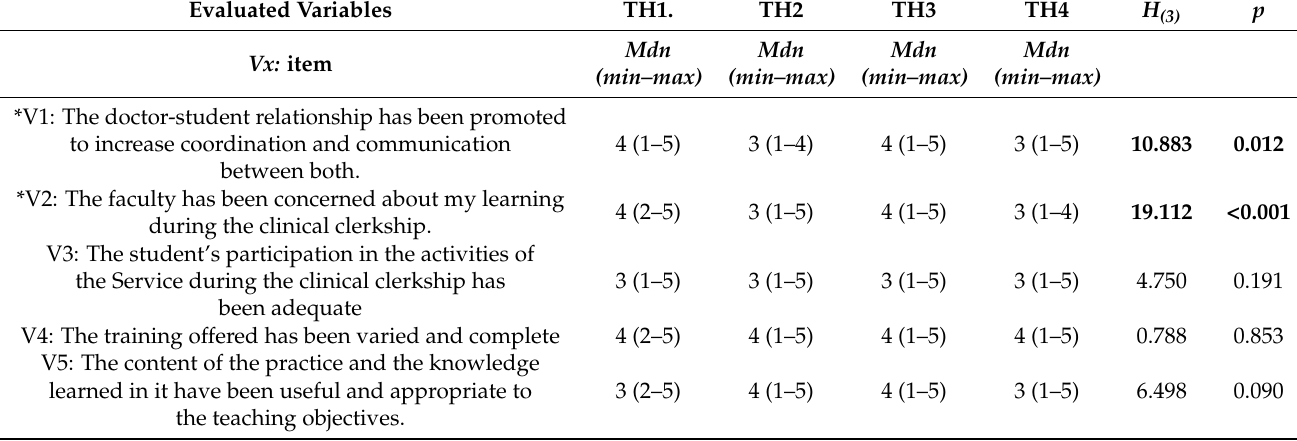
Table 3. A Comparison of the Four Teaching